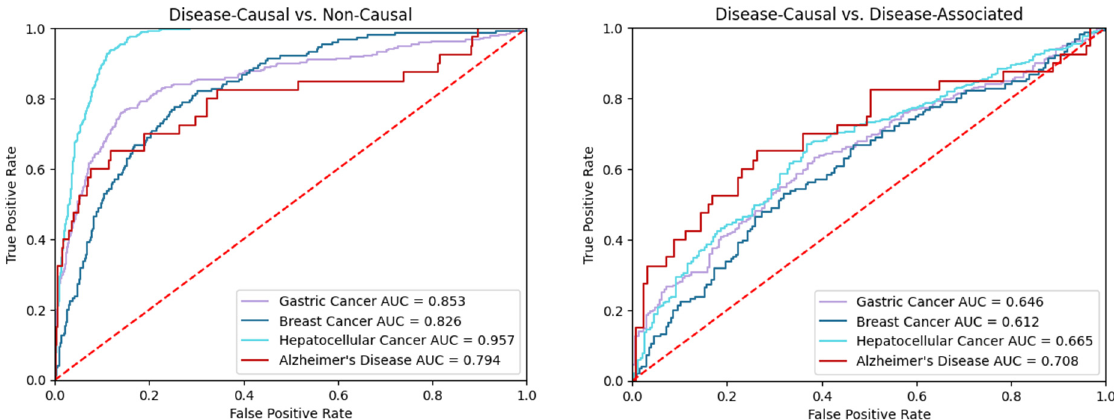
Figure 6. These AUCs demonstrate that DisiMiR can differentiate between disease causal and non- causal miRNAs, as well as disease causal and disease-associated miRNAs. Left : The AUCs from DisiMiR’s average predictions across 100 random splits. Right : The AUCs from DisiMiR’s average predictions across 100 random splits for disease-associated miRNAs only.